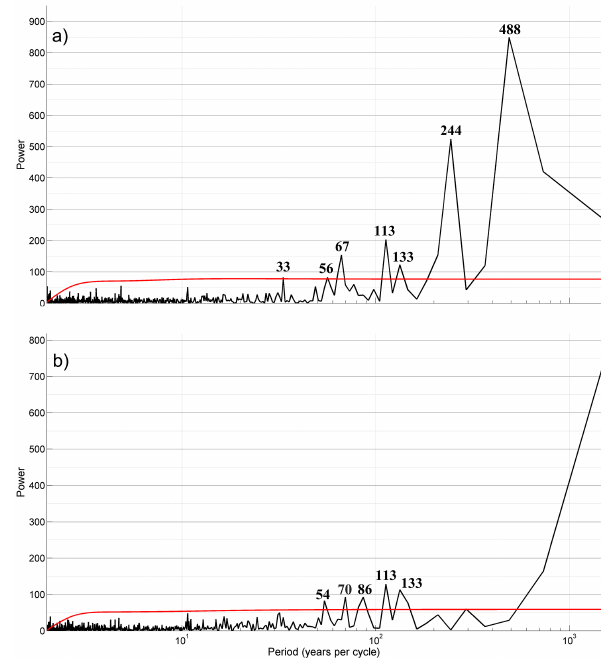
Figure 5. TORN-RC1SFC (a) and FENN-RC2SFC (b) spectrum. Red line shows power spectrum of red noise with lag 1 autocorrela- tion estimated from the series. Period: AD